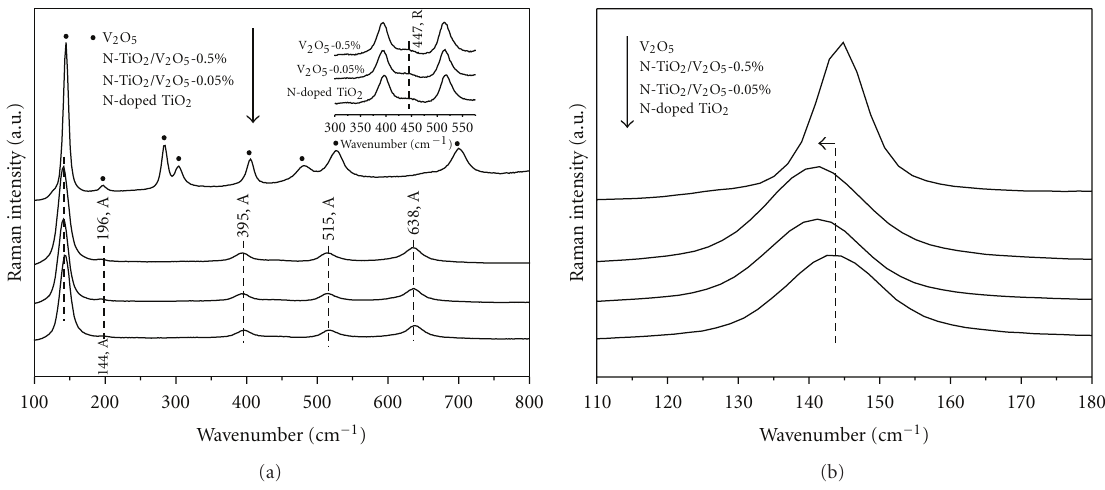
Figure 2: Raman spectra of N-doped TiO 2 , selected V 2 O 5 cluster modified N-TiO 2 and V 2 O 5 samples (A: anatase, R: rutile).